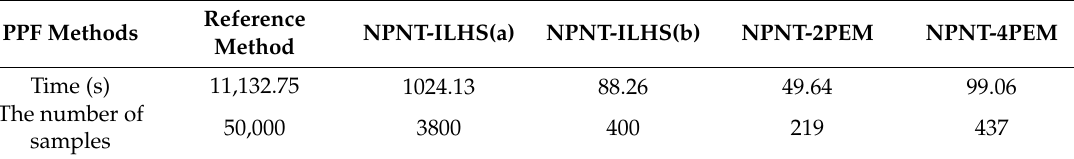
Table 8. The computational time and the number of